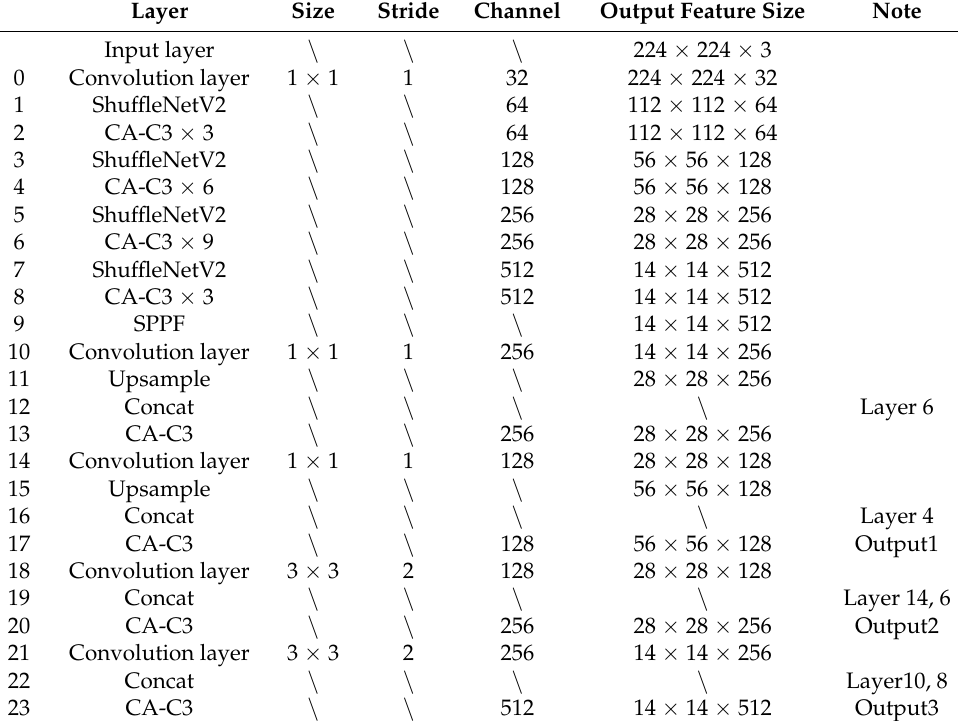
Table 1. The detail architecture information of improved YOLOV5.